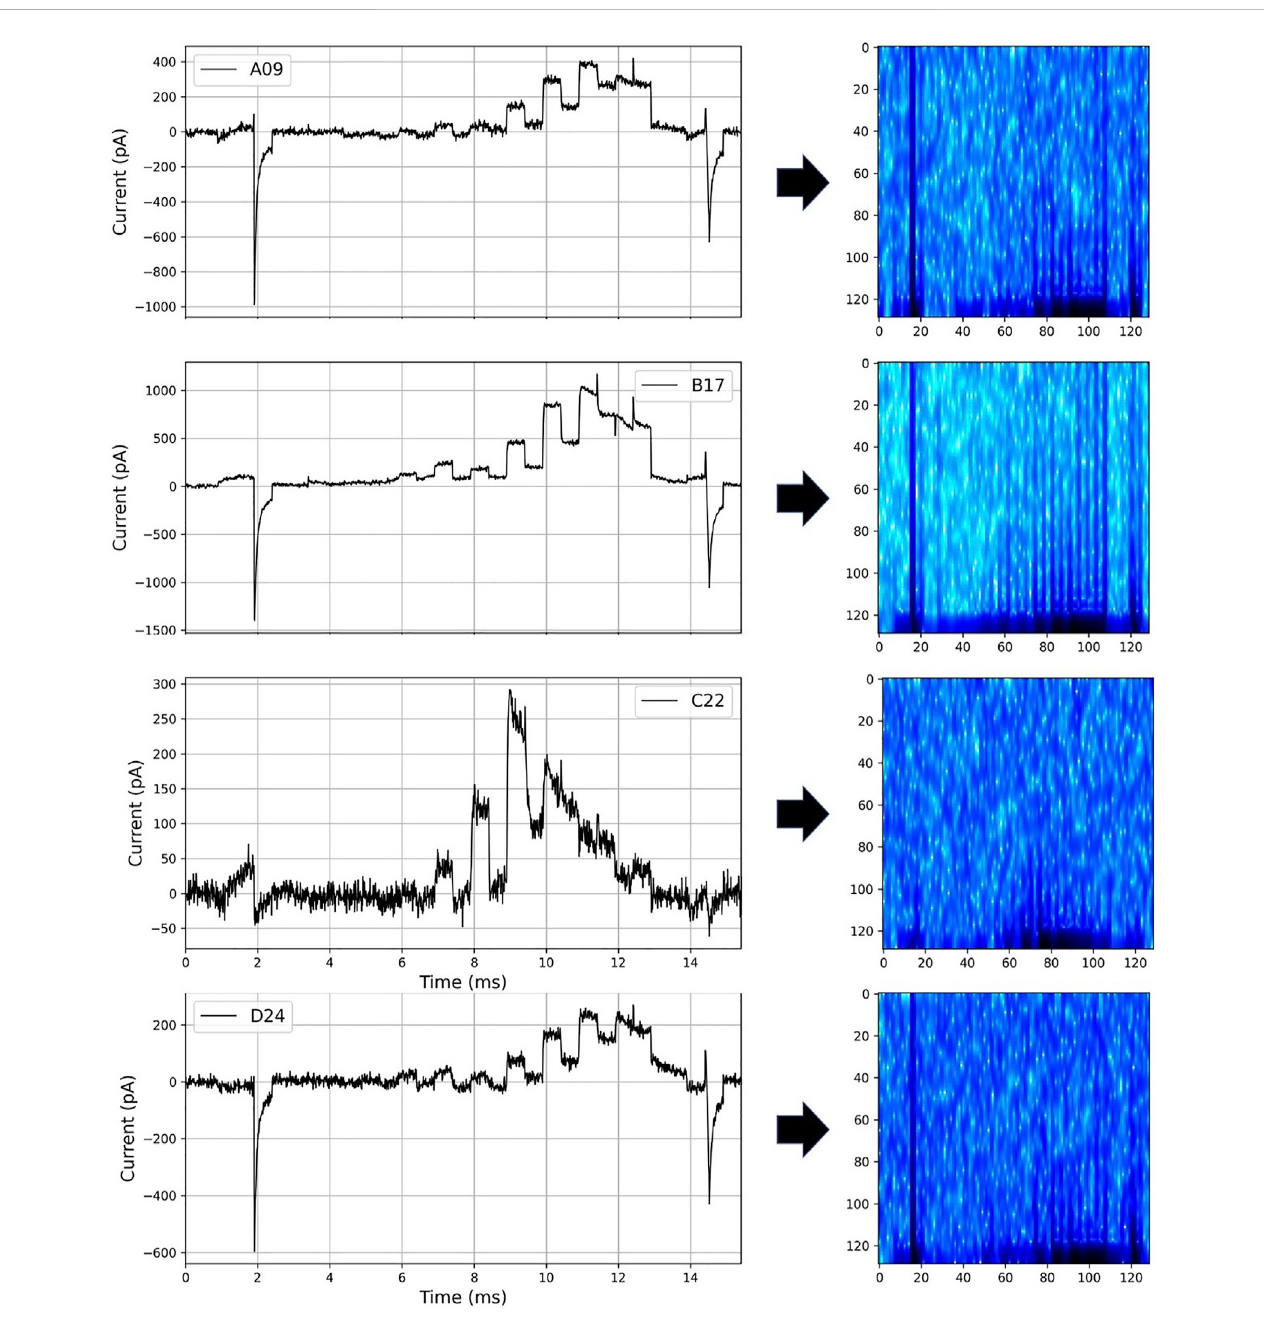
FIGURE 6 Spectrograms transformed from current data for 4